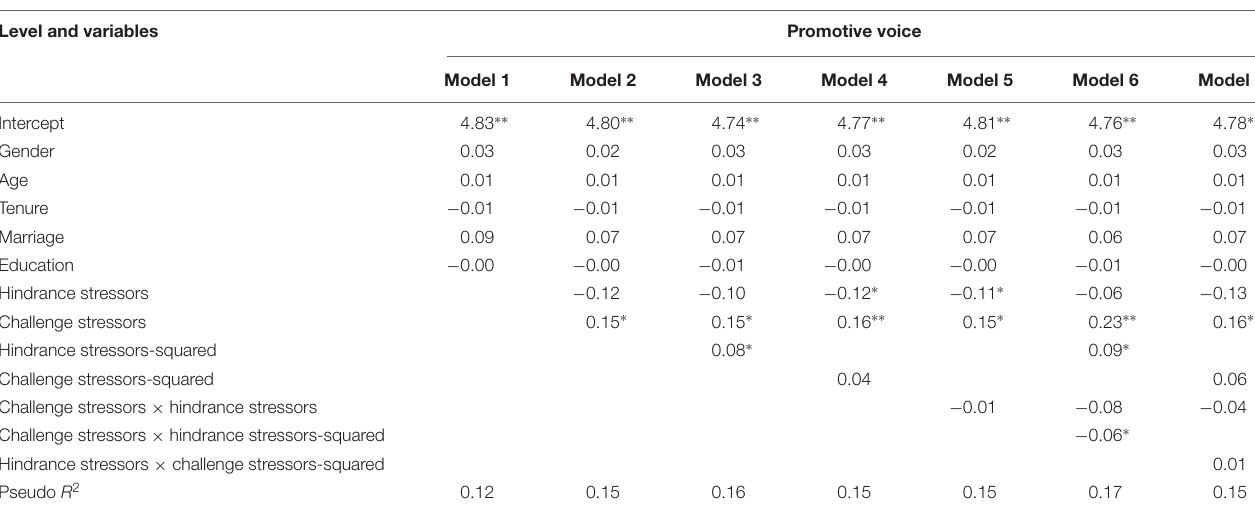
TABLE 4 | The relationship between stressors and promotive